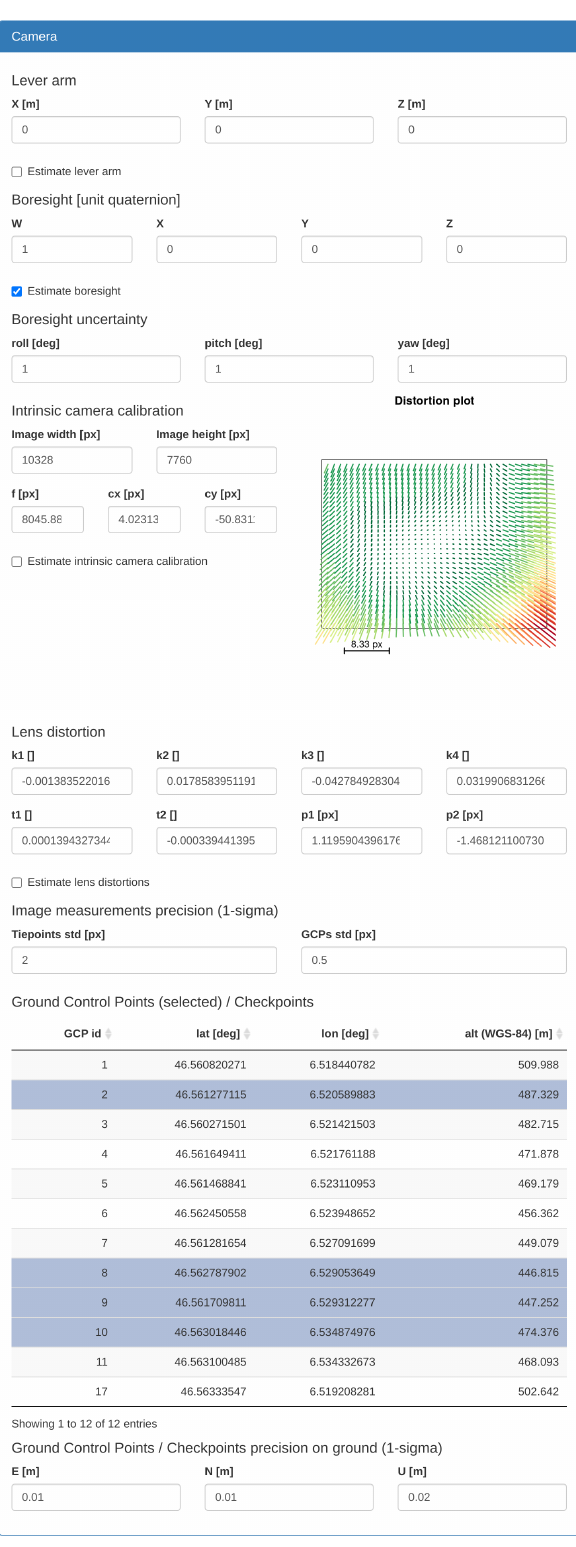
Figure 4. Camera configuration panel.